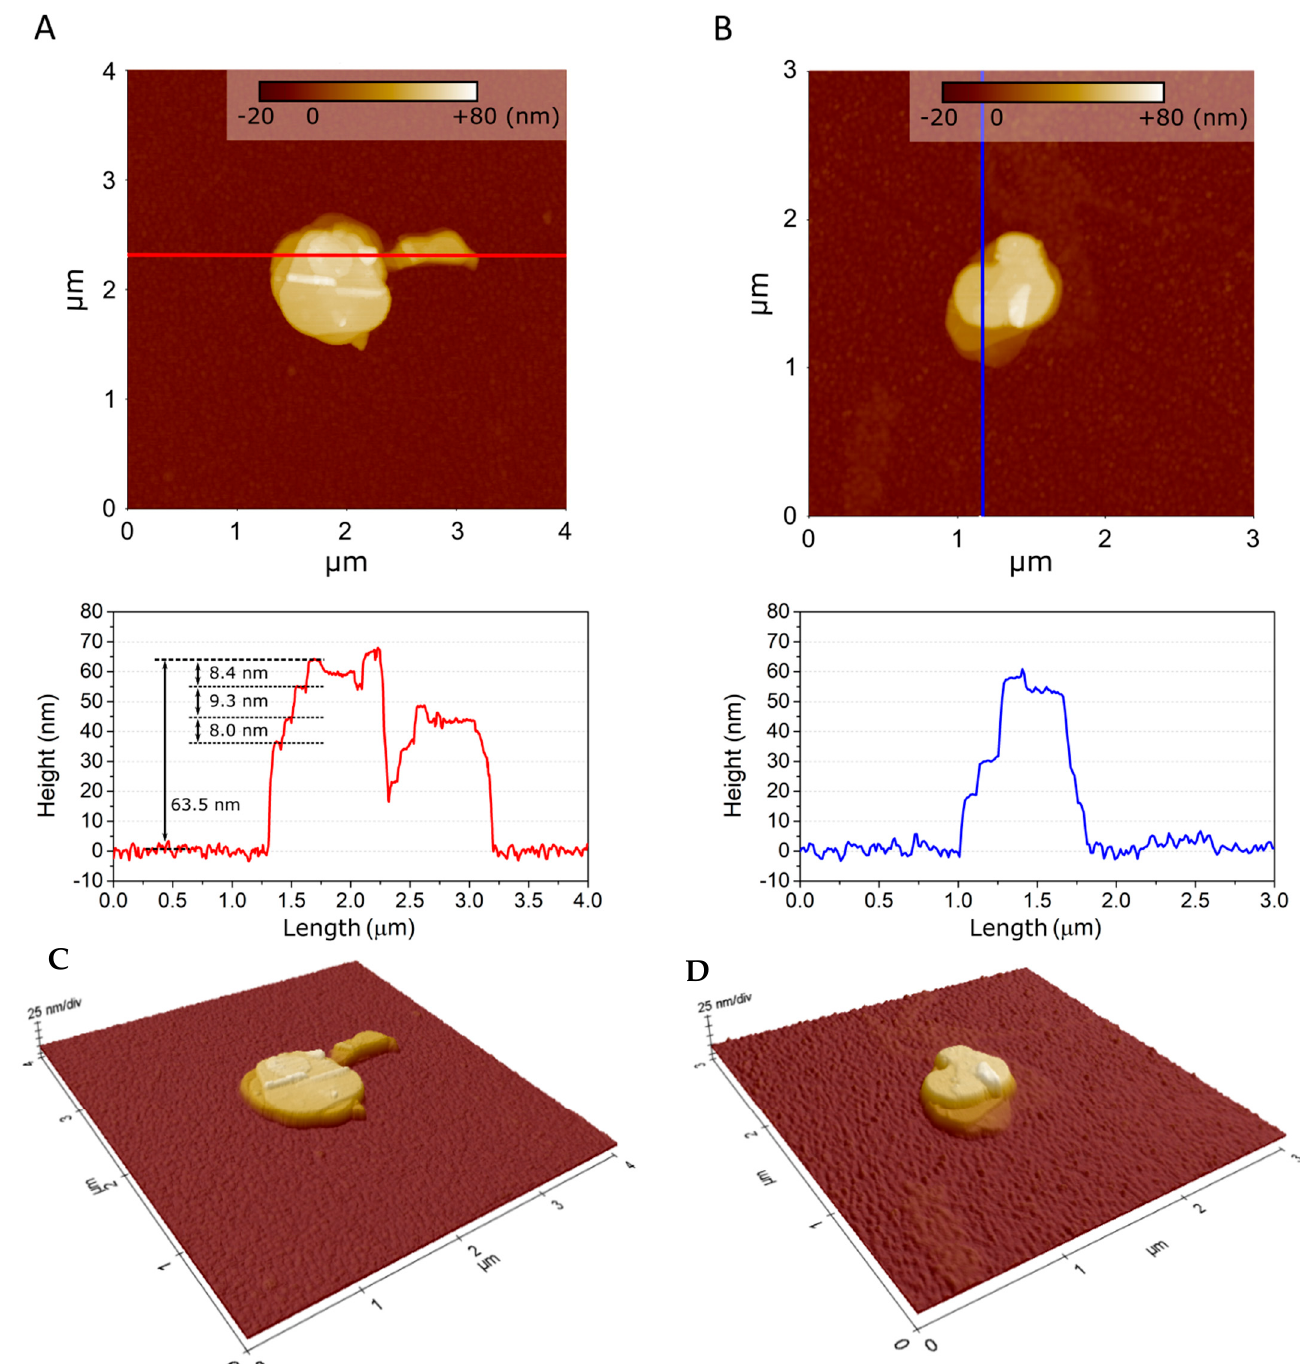
Figure 5. AFM images of ( A ) single BN flakes obtained from water exfoliation, with corresponding line profile; ( B ) BN flakes from NMP exfoliation, with corresponding line profile. Three-dimensional AFM images of single BN flakes obtained from ( C ) water exfoliation and ( D ) NMP exfoliation (images taken using 3× magnification on z-axis).